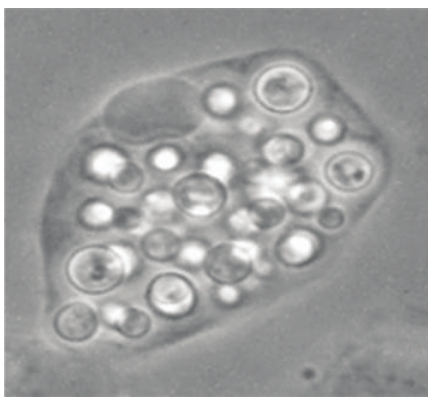
Figure 1: Cryptococcus neoformans can proliferate to a density of hundreds of yeast cells within macrophages. Here a J774 macrophage has been partially lysed to reveal intracellular C. neoformans after 18 hr of incubation. Image: W.